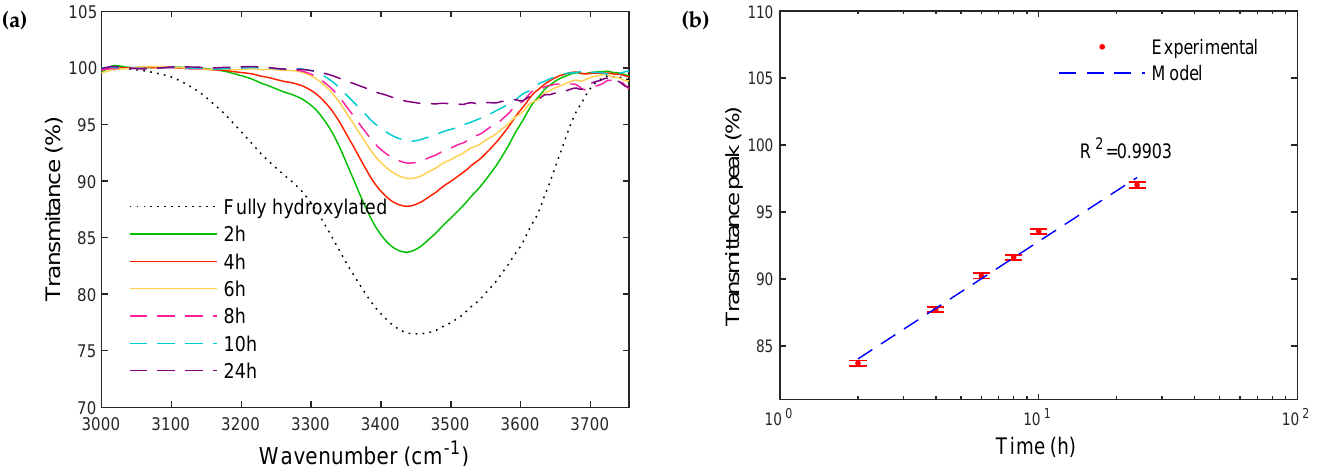
Figure 4. ( a ) Infrared spectra of initially rehydroxylated glass particles, as a function of the subsequent calcination time at 450 ◦ C. ( b ) Evolution of the transmittance peak T as a function of calcination time at 450 ◦ C. The dotted blue line corresponds to the linear regression of the Transmittance as a function of log ( t ) for the peak located in-between 3430 cm − 1 and 3500 cm − 1